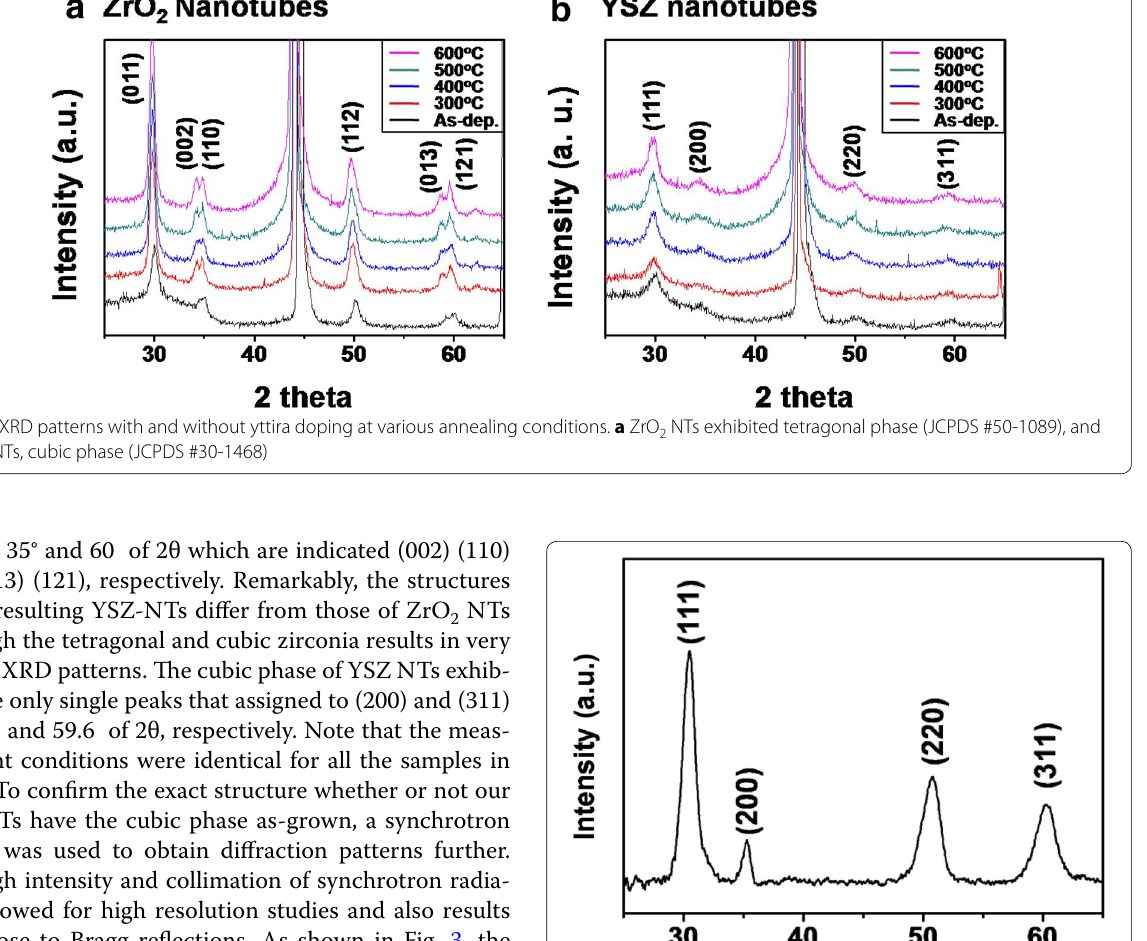
Al foil and AAO template as mechanical supports. On the top side, the Pt electrode was formed inside the alu- mina membranes to prevent electrical contact with the aluminum ring. From the bottom side, we clearly veri- fied that the dimension of the free-standing MEA area is 7 mm in diameter. The SEM images show that porous